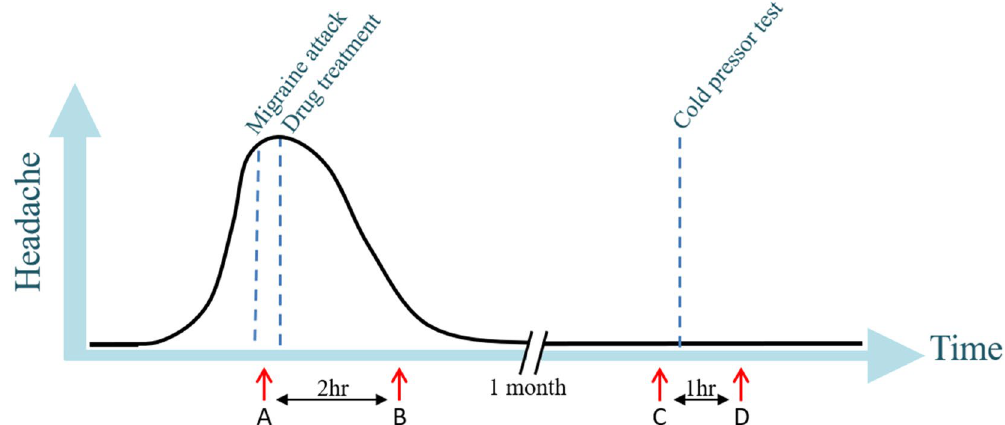
Figure 1. Study design with on the x-axis the time and on the y-axis the degree of headache. Blood sampling (marked by red arrows) was performed during migraine attack ( A ), two hours after treatment ( B ), one month later outside attack at a headache-free day ( C ) and after performing a cold-pressor test ( D